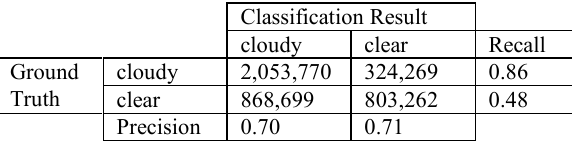
Figure 6. OA (blue), BA (orange), F 1 cloud (green), F 1 clear (red) for all test sites and single test sites